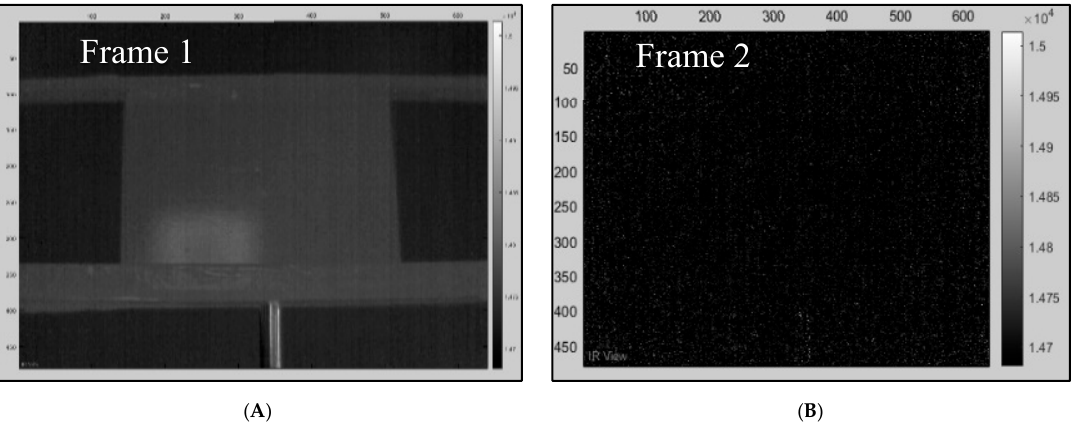
Figure 6. The method strategy according to an active thermographic test.